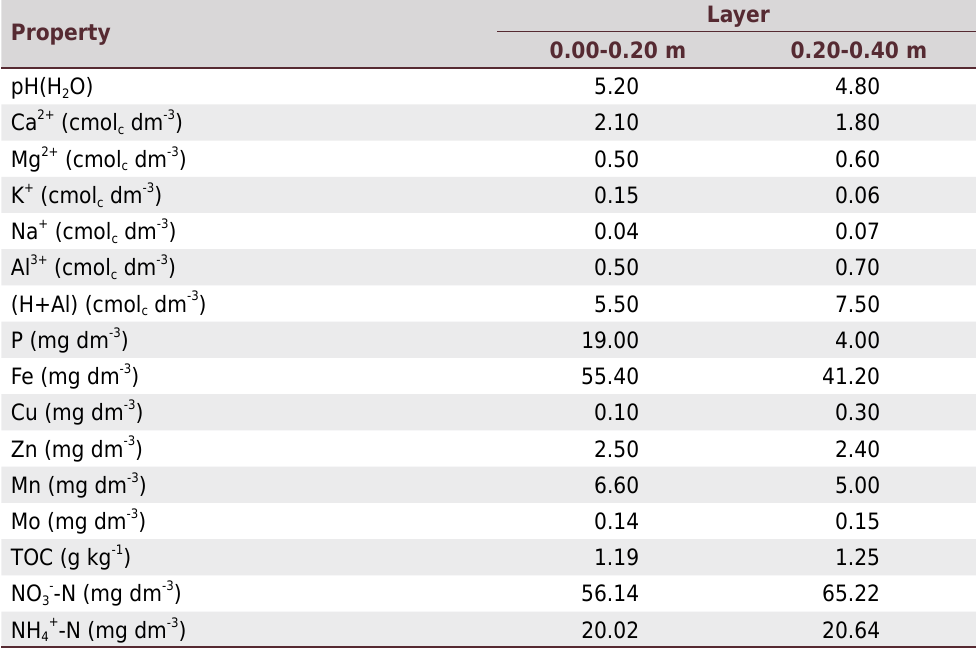
Table 1. Soil chemical properties in different layers in the field experiment area at Sugarcane Experimental Station of Carpina, Brazil